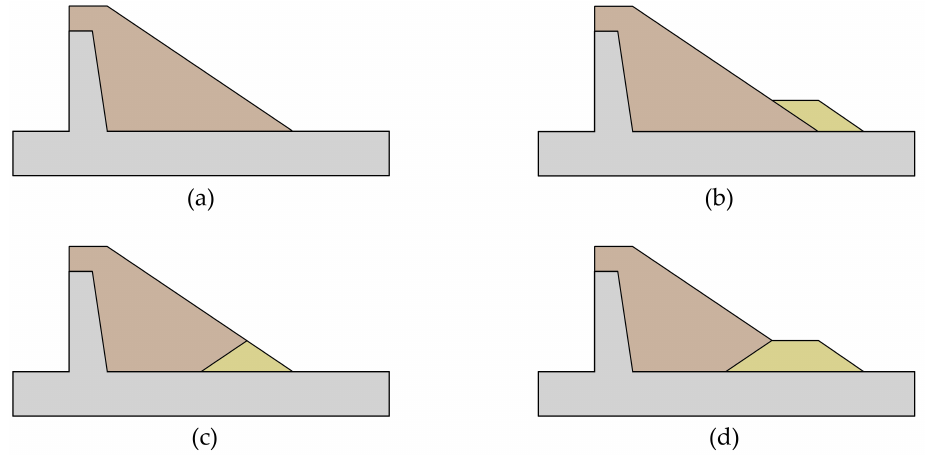
Figure 2. Displaying the investigated toe configurations, where ( a ) shows no toe configuration, ( b ) external toe, ( c ) internal toe and ( d ) combined toe